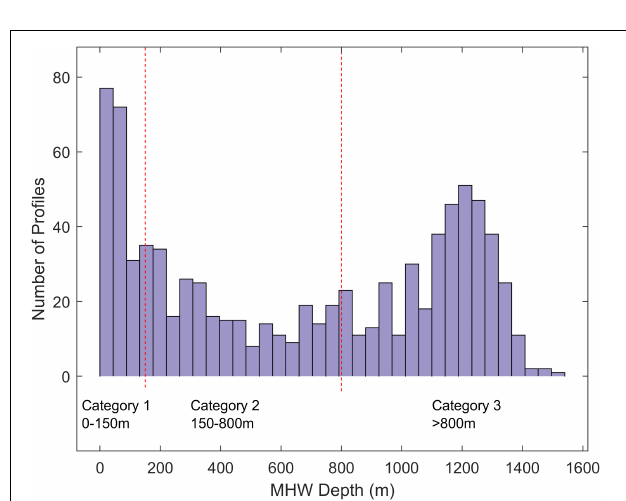
FIGURE 5 | Marine heatwave depth for Argo float profiles. Three categories were identified: 0–150 m (shallow), 150–800 m (intermediate) and > 800 m (deep). Depths bins have 50 m